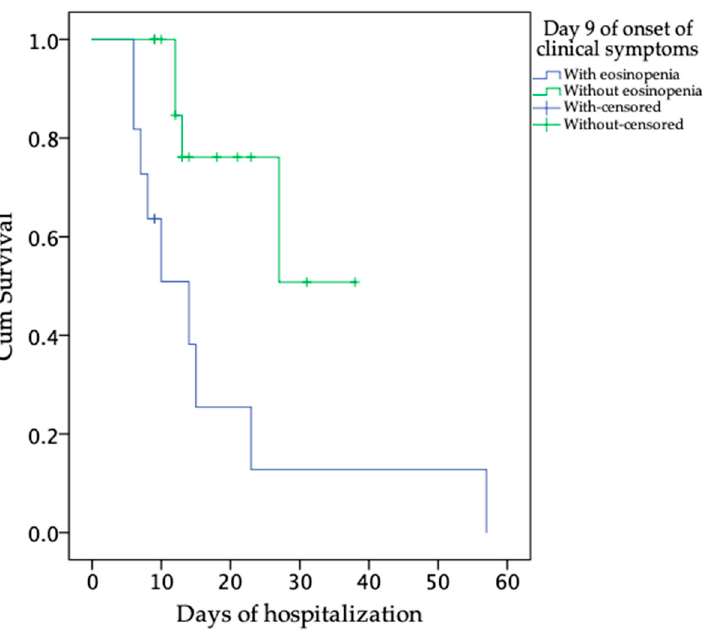
Figure 4. Kaplan–Meier survival function from the time of admission to the time of death in COVID- 19 patients with eosinopenia (eosinophil counts < 0.01 × 10 9 /L) and without eosinopenia at Day 9 of onset of clinical symptoms. The probability of survival was within a period of 3 to 57 Days—that is, the period in which the cohort of COVID-19 patients analyzed remained hospitalized. Recovered patients ( n = 15); deceased patients ( n = 14).